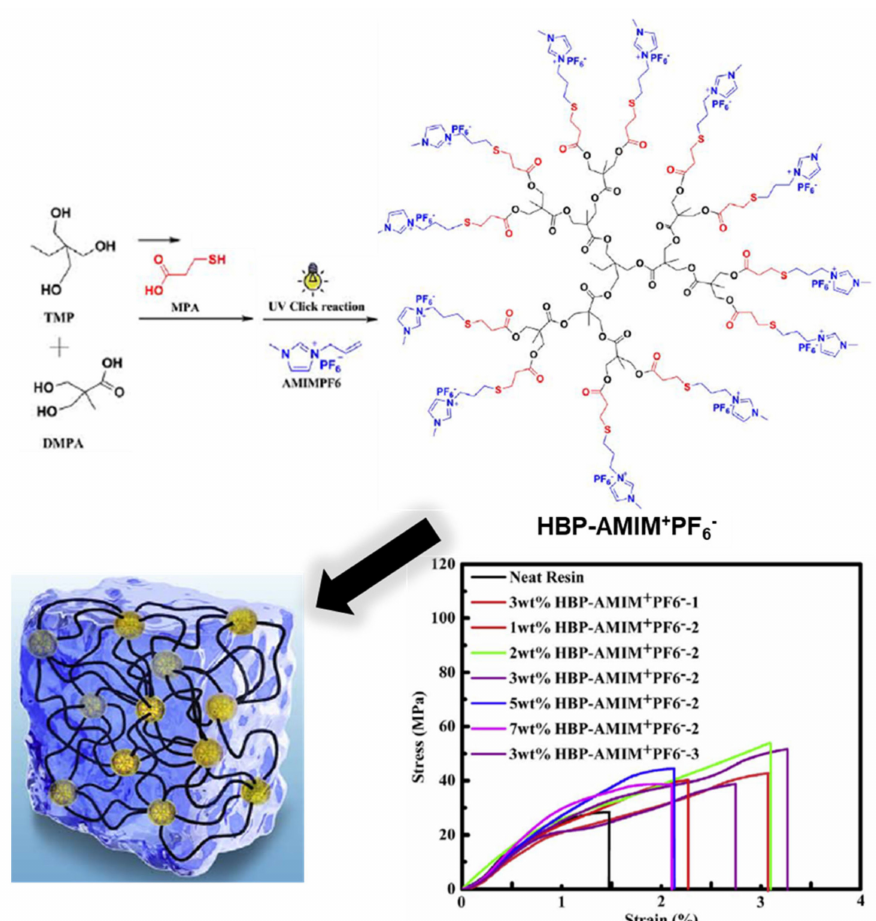
Figure 55. ( a ) Synthesis of hyperbranched polyester ionic liquids. ( b ) Representative stress − strain curves [352]. Copyright 2017. Reproduced with permission from Elsevier B.